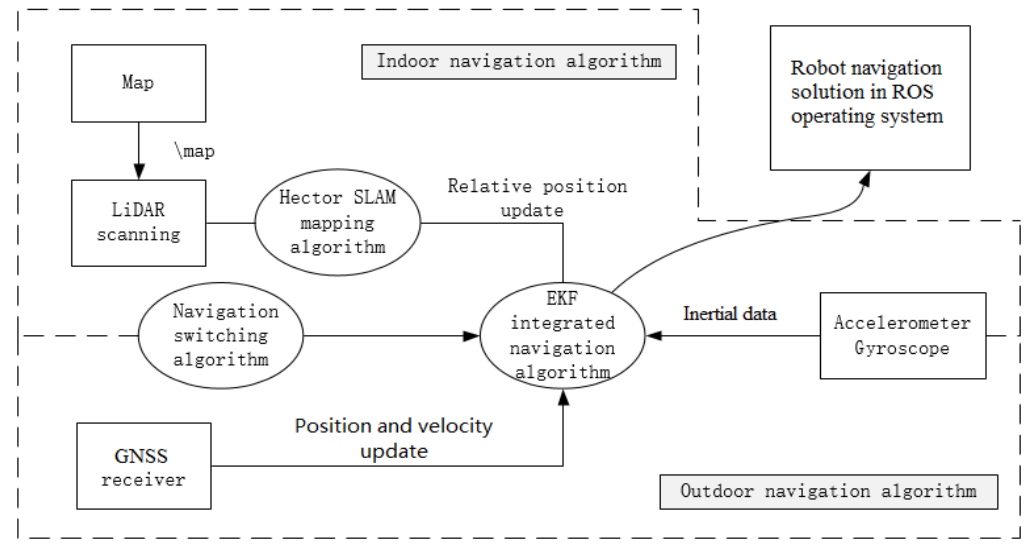
Figure 1. Schematic diagram of Inertial Navigation System (INS)/Global Navigation Satellite System (GNSS)/Light Detection and Ranging (LIDAR)